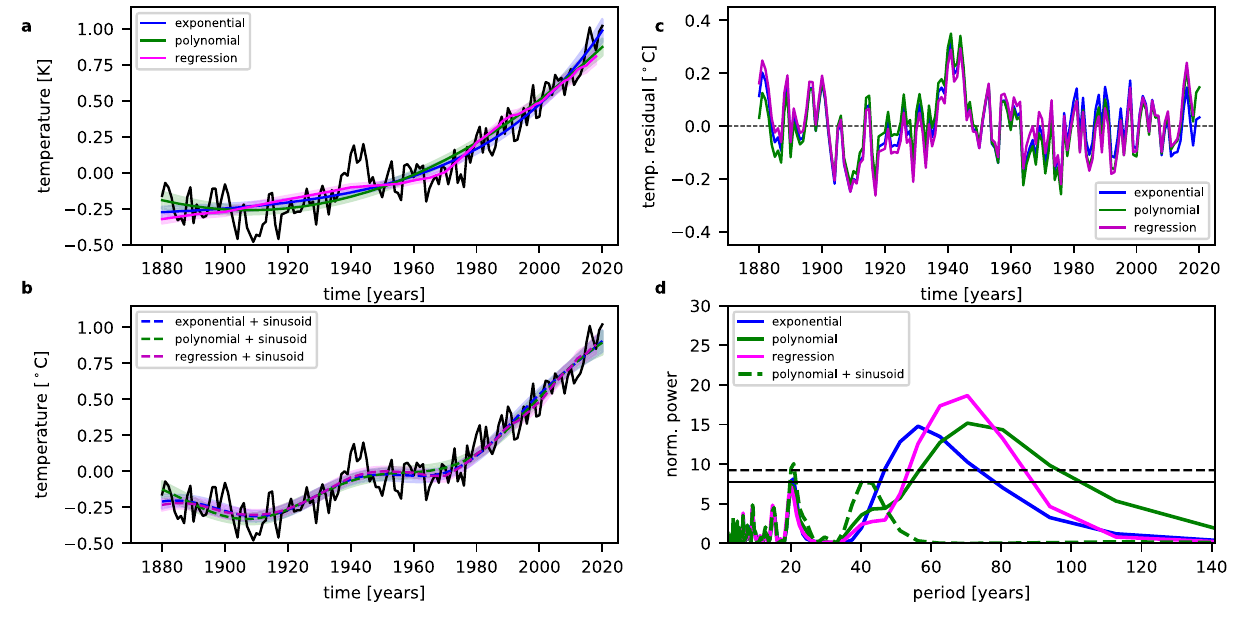
Figure 1. Comparison of different long-term trend descriptions. ( a ) The global annual mean surface temperature anomalies (GISTEMP v4) are shown as black curve. The fits of an exponential function, a second- degree polynomial, and the regression using the radiative forcing are shown in blue, green, and magenta, respectively. ( b ) Same as in ( a ) but with an additional sinusoid in the fits. The coloured areas show the 2σ uncertainties of the fits in all cases. Because of the end of the radiative forcing time series in 2018, the fit using the correlation also ends in 2018. ( c ) The residual temperatures (original temperature time series—fit) for the three different long-term trend descriptions are shown with the same colours as in ( a ) and ( b ). ( d ) Lomb-Scargle Periodogram of the detrended time series of surface temperature anomalies. The different fit functions used for the detrending are shown with different colours. The LSP is evaluated at 278 evenly spaced frequencies in the range f = 1/2 year −1 to f = 1/141 year −1 . The black solid line and the dashed black line display the levels for false alarm probabilities of 5% and 1%, respectively. In the case of the correlation analysis, these levels are slightly lower, because of the shorter length of the time series and the smaller possible maximum peak. However, the difference can hardly be